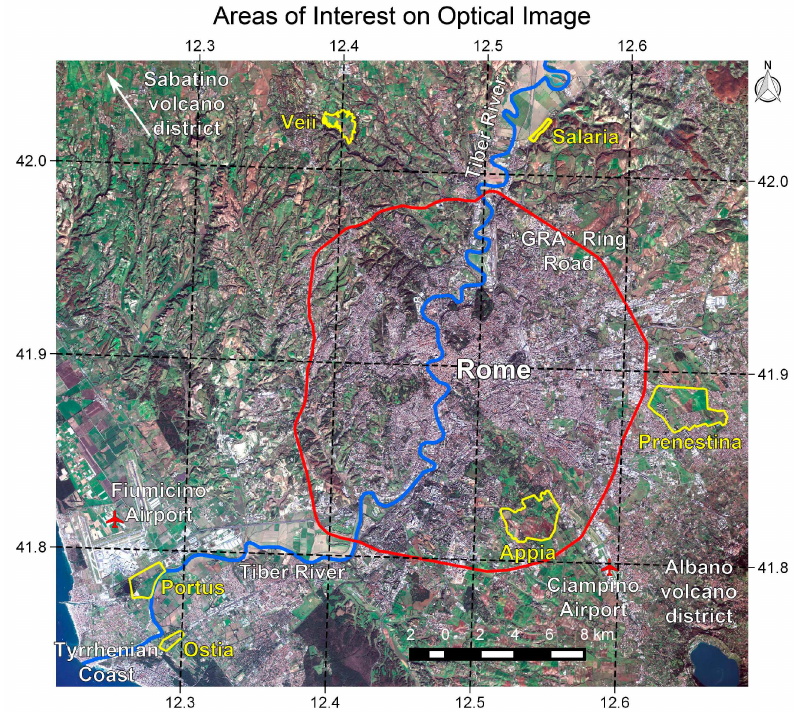
Figure 3. Areas Of Interest (AOIs) shown as yellow polygons on true colour, 10 m resolution Sentinel-2 image acquired on 28 December 2015 (bands 4, 3 and 2 displayed as red (R), green (G) and blue (B) respectively). Contains modified Copernicus Sentinel data 2016.